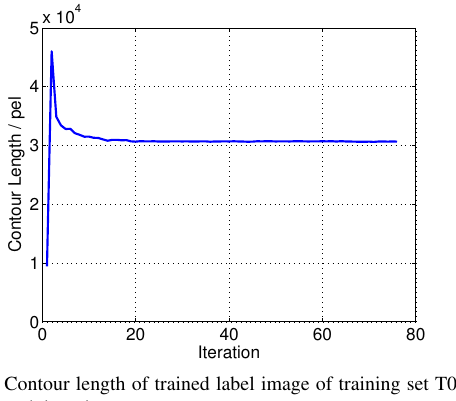
(c) Contour length of trained label image of training set T02 for each iteration. Figure 6: Results of the refinement process for each of 75 iterations. Four characteristics as discussed in section 3.4 are plotted.